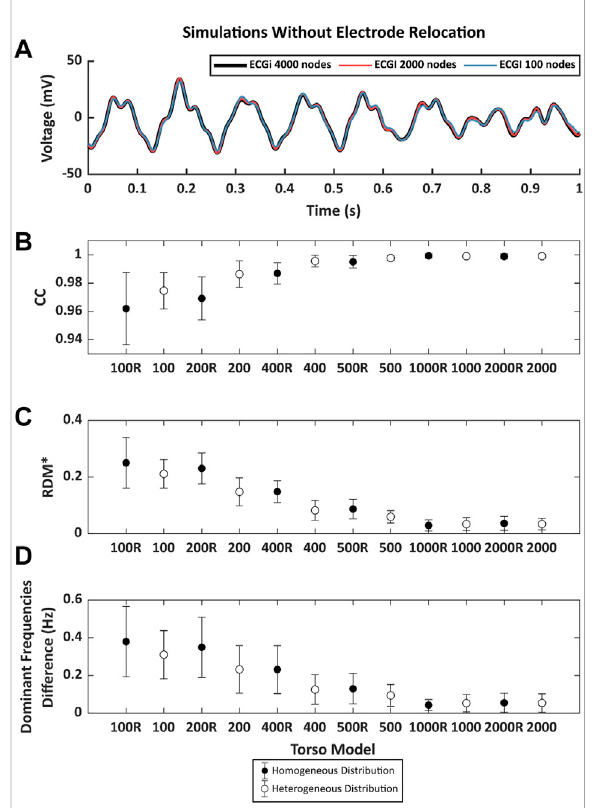
FIGURE 4 (A) . Example of 1 s of inverse computed electrograms obtained with different torso models and the same simulation signals for torsos without electrode relocation. Signal in black was obtained with the reference 4000-node torso, red and blue signals correspond to the ones obtained with torsos of 2000 and 100 nodes respectively. (B) . Pearson ’ s correlation coef fi cient (CC), (C) . relative measurement (RDM*) and (D) . mean absolute difference between the reference dominant frequencies (DF) between torso models and from 100 to 2000 nodes. Points in black represent the mean value of the metrics torsos in which the distribution of the nodes is homogeneous and white points represent the torso with nodes heterogeneously placed. Whiskers represent the standard deviation. relocation (Figure 6). First, an example of simulated ECGI signals of the reference torso with coarser meshes is presented in panel Figure 6A. Although the overall shape of the inversely computed electrograms is preserved for lower mesh densities, some impact of shape morphology can be observed, especially for the sparser meshes (blue line). A global comparison between the signals measured through time-metrics is represented in Figures 6B,C for all the models. The CC and the RDM* show a strong dependency on torso mesh density. A progressive increase is shown for the CC as the number of nodes increases, from 0.53 ± 0.06 for the 100 mesh to 0.92 ± 0.04 for the 2000 node mesh. Besides, the RDM* decreases when the torso is composed with a higher number of vertices from 0.96 ± 0.07 for the 100 mesh